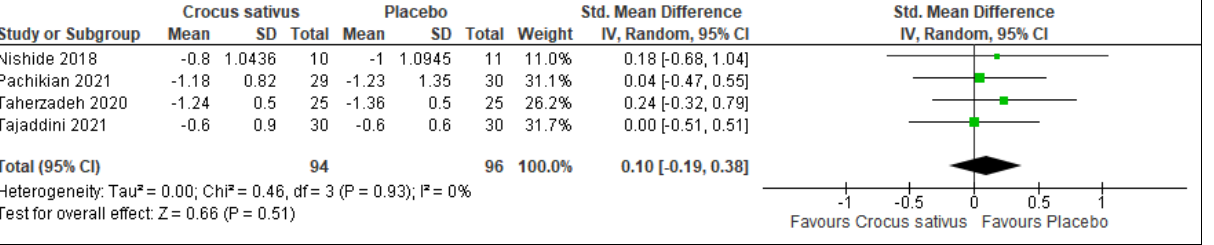
Figure 6. Forest plot for the outcome sleep latency [26,27,29,30]. Note: Line indicates confidence interval and the green square indicates effect estimate. Black diamond indicates cumulative effect estimate and its confidence interval.